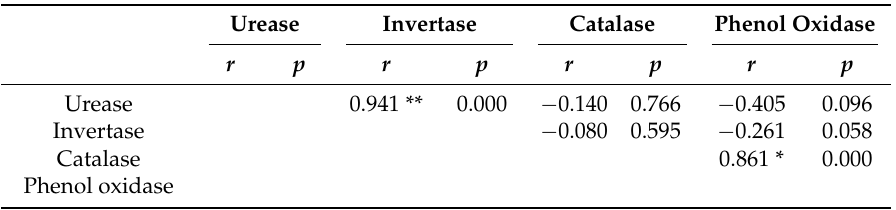
Table 3. Correlation among soil enzyme activity.